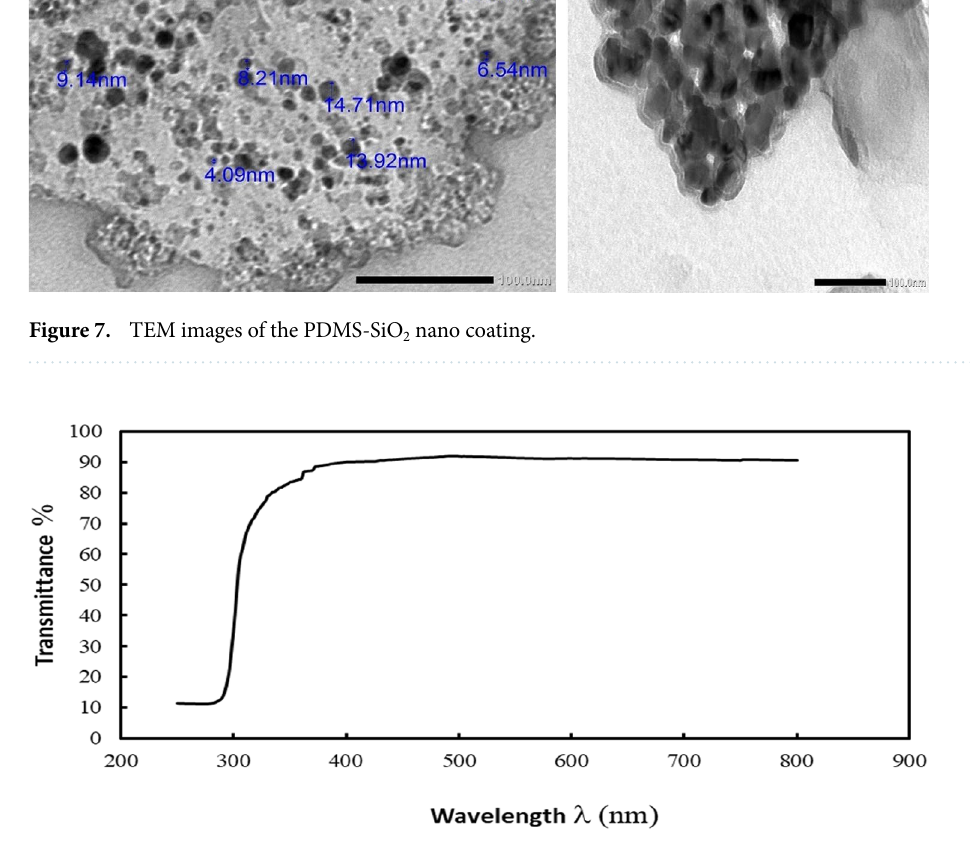
Figure 8. The UV–Vis spectroscopy of the PDMS/SiO 2 nanocoating.